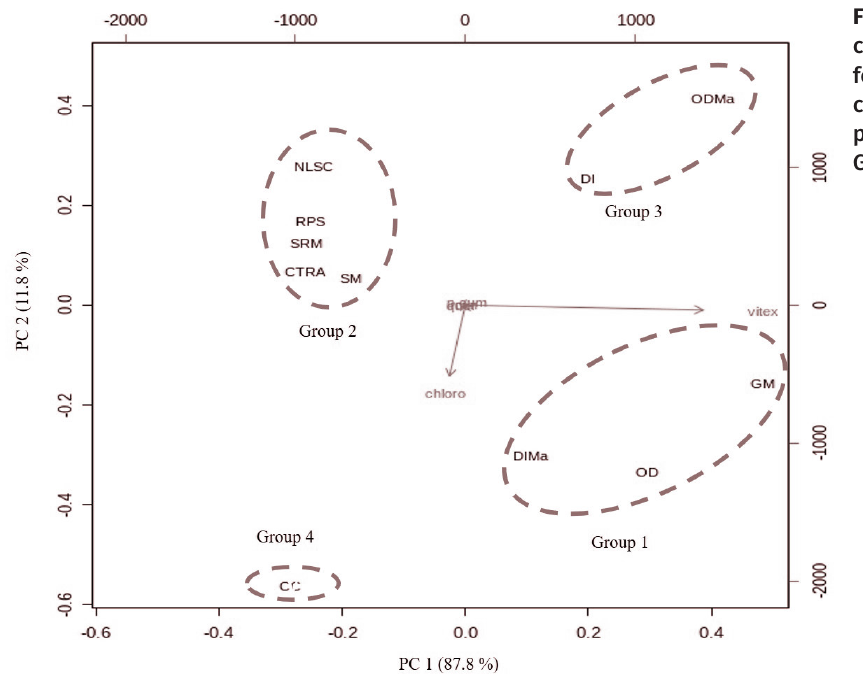
Figure 3. Biplot of principal component analysis (PCA) for samples and phenolic constituents from L. pinaster populations, state of Minas Gerais,